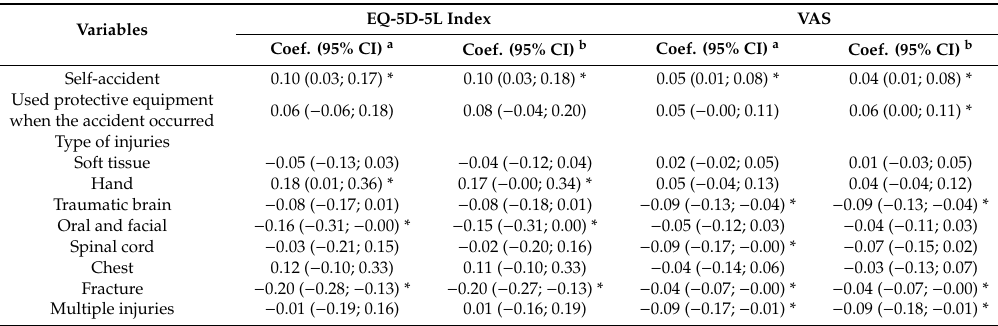
Table 3. The factors associated with HRQOL of